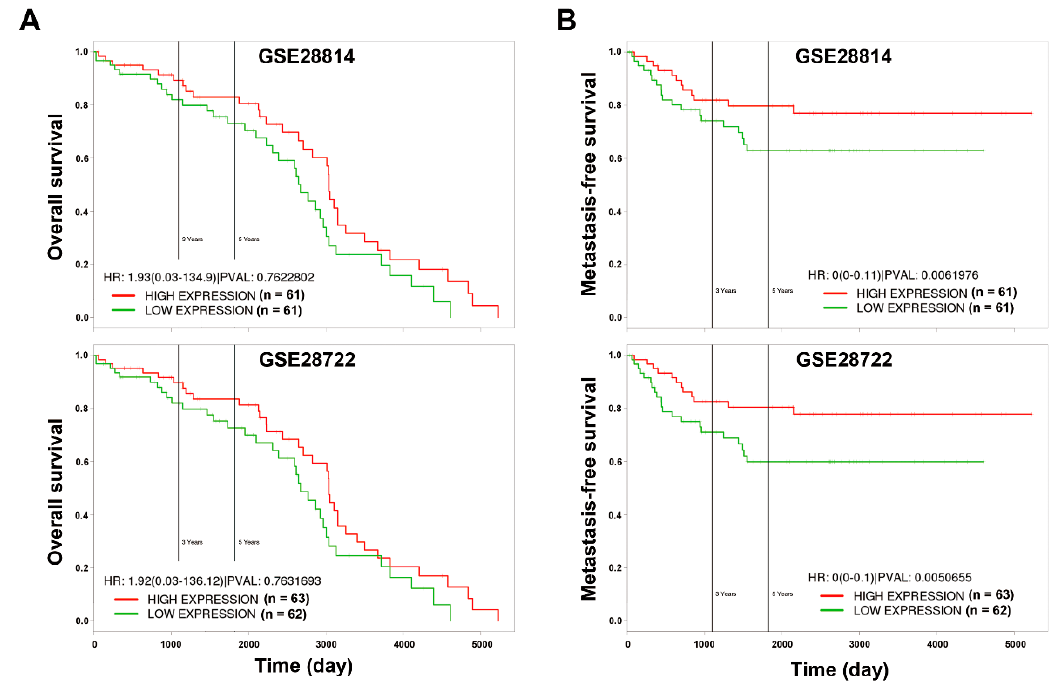
Figure 6. Prognostic impacts of proteasome gene alterations on overall ( A ) and metastasis-free ( B ) survival in colorectal cancer (CRC). The prognostic impact of the miR-21-downregulated proteasome gene signature (PSME3, PSMA1, PSMA2, PSMA3, PSMB2, PSMB3, PSMB4, PSMB5, PSMB8, PSMB10, PSMC2, PSMC3, PSMC4, PSMC5, PSMC6, PSMD3, PSMD4, PSMD11, PSME1, PSMF1, and PSMD6)